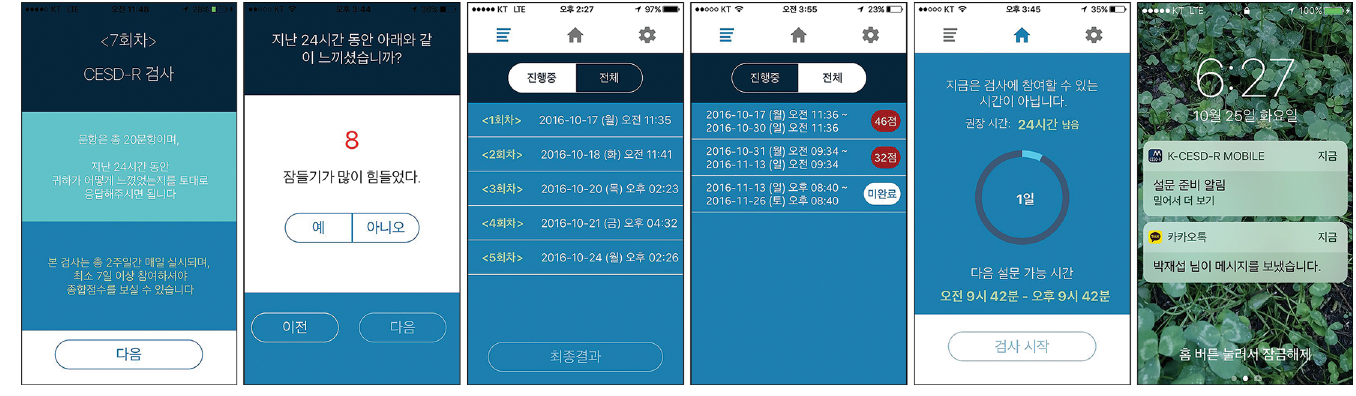
PLOS ONE | https://doi.org/10.1371/journal.pone.0199118 June 26,